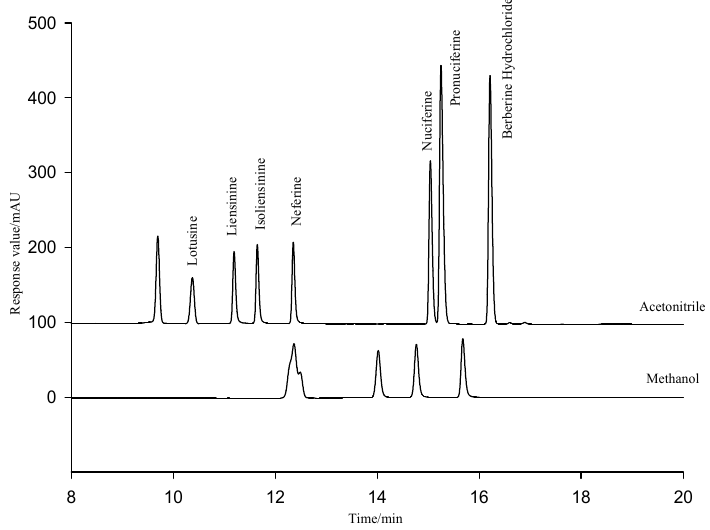
Figure 3. Chromatograms of different mobile phases.